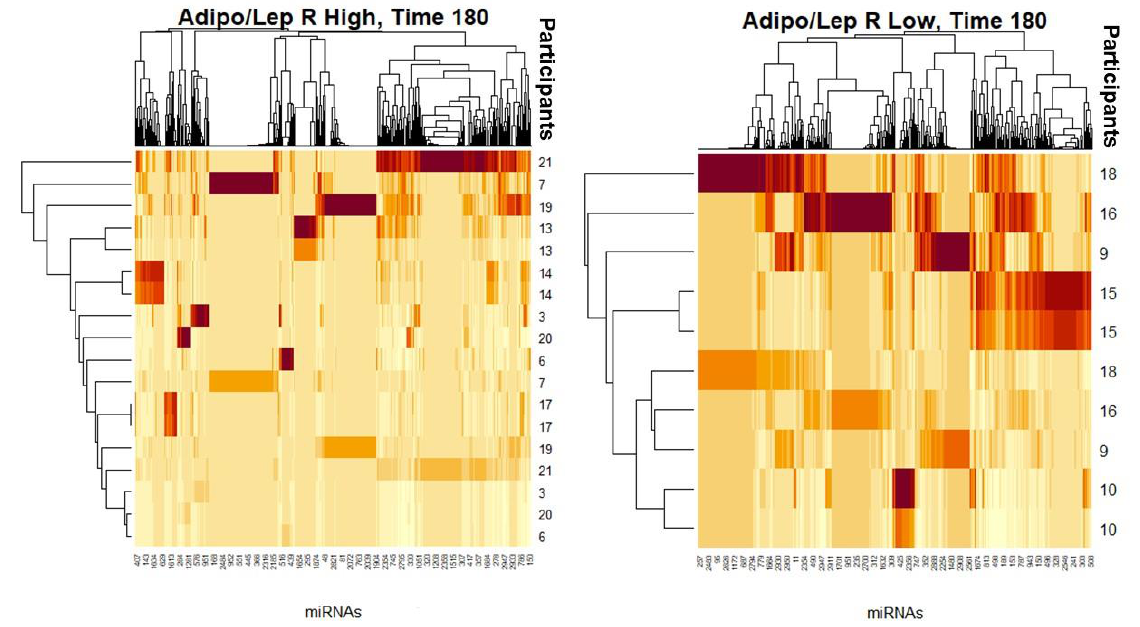
Figure 3. Volcano plot with differences in lipidomic signatures for Time 180 ′ (peak of postprandial response) after a mixed meal among participants with (H) vs. (L)ALR. Individual lipid classes and species are shown in boxes (right).